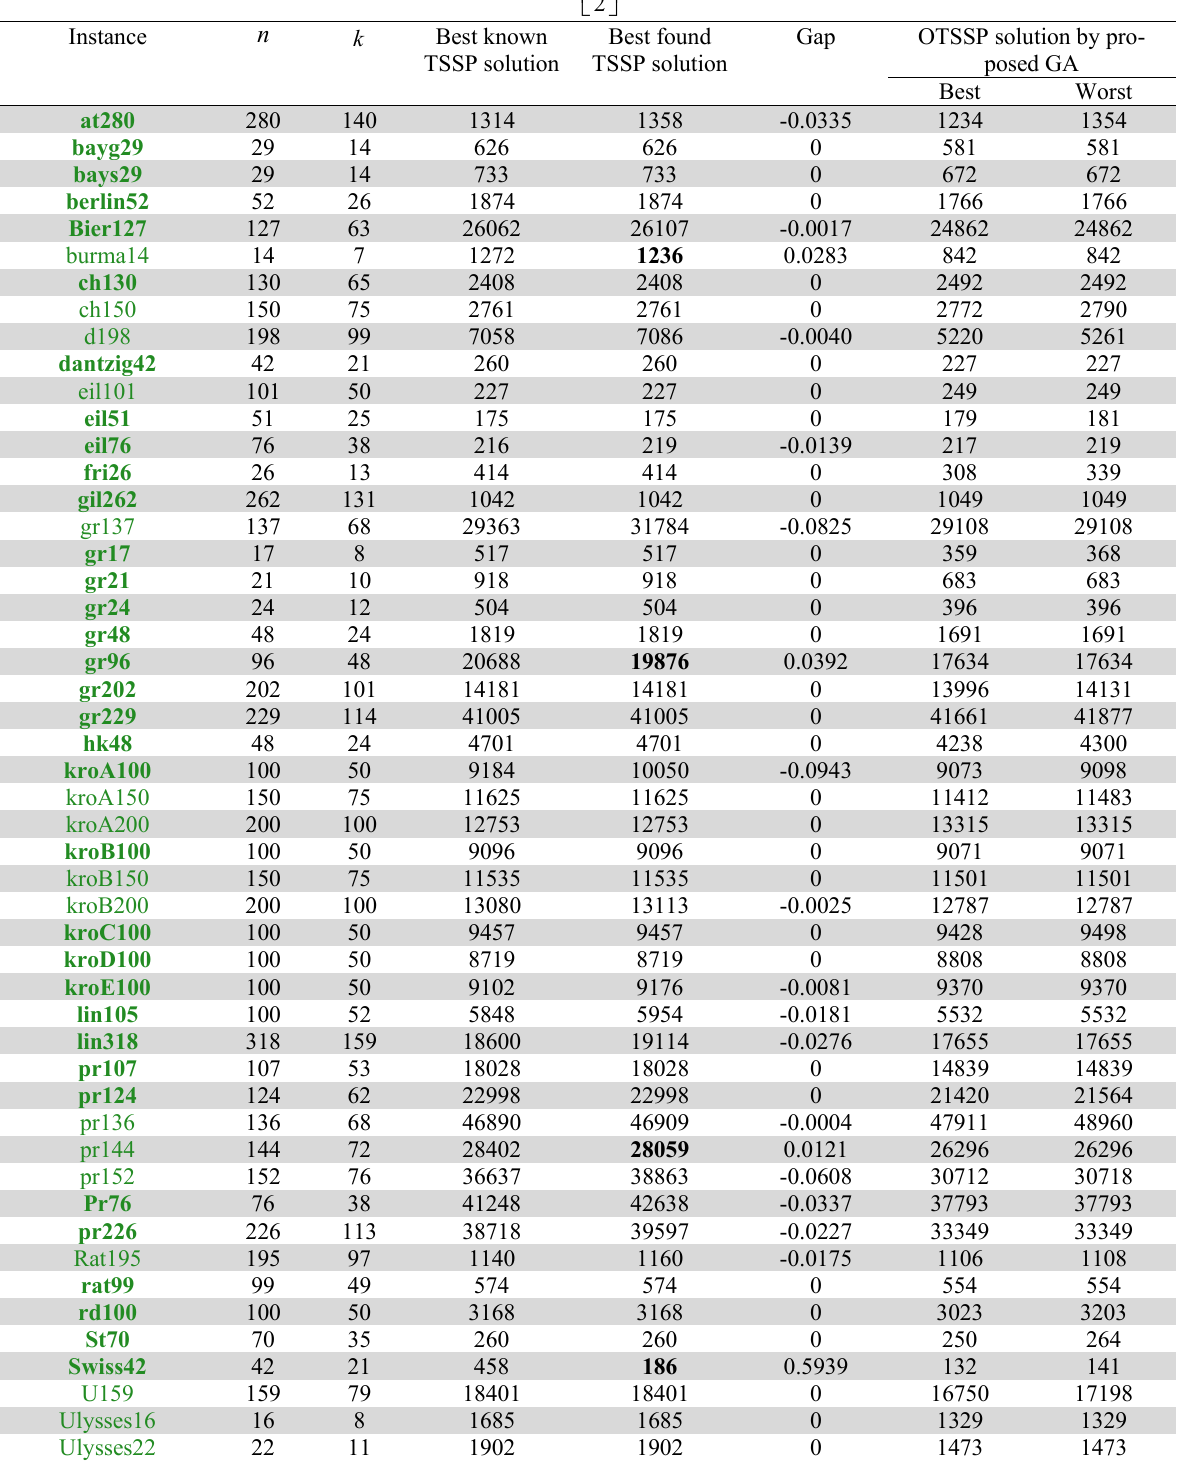
Computational results of proposed GA on instances